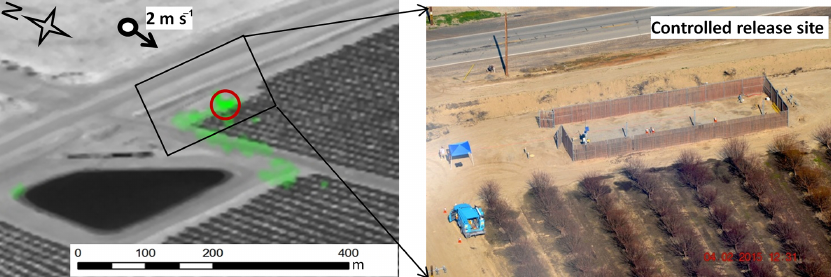
Figure 10. Example of HyTES-detected methane (green) with overlay on grayscale surface temperature (left) at the natural gas controlled release site (inset photograph). Detected methane in the HyTES image is displayed in green with the higher intensity color corresponding with highest concentration of methane at the release point circled in red. Table 2. Results from a controlled release experiment on 28 April 2015 where natural gas was released from a ∼ 2m high stack at a pressure- regulating station near Bakersfield, California. Aircraft altitude, fluxes (SCFH is the standard cubic feet per hour), wind speed, pixel size, and maximum (dMax) and total values (dTotal) of CH 4 calculated from the clutter matched filter (CMF) and CH 4 retrieved concentration values (ppm) are shown, where dMax = [max(CH 4 ) − BKG], and dTotal = [Sum(CH 4 ) − BKG], where BKG is the average CH 4 background value of pixels in which no plume was detected. CMF results Retrieval results